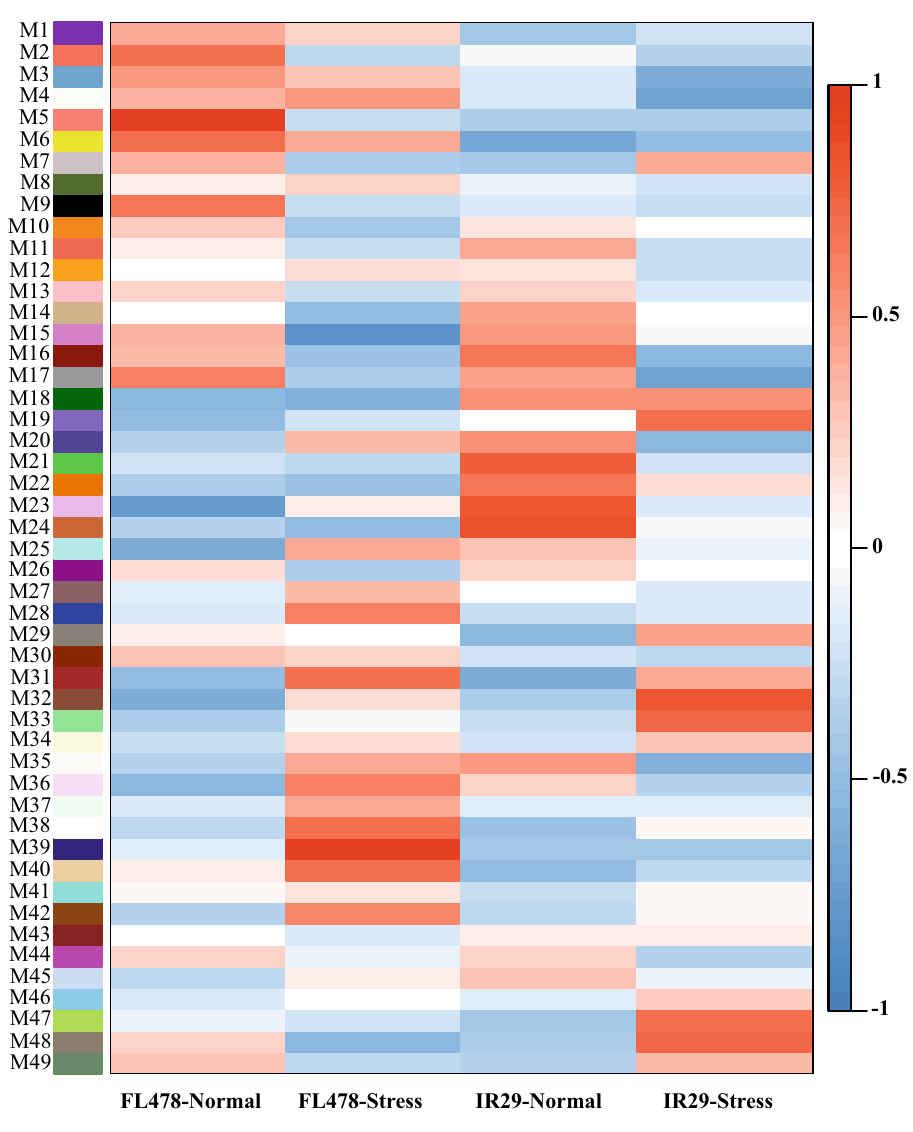
Figure 4. A visual representation of the 49 modules correlated with salt stress response. The heat-map scale reflects the correlation (r 2 ) level among lncRNAs and